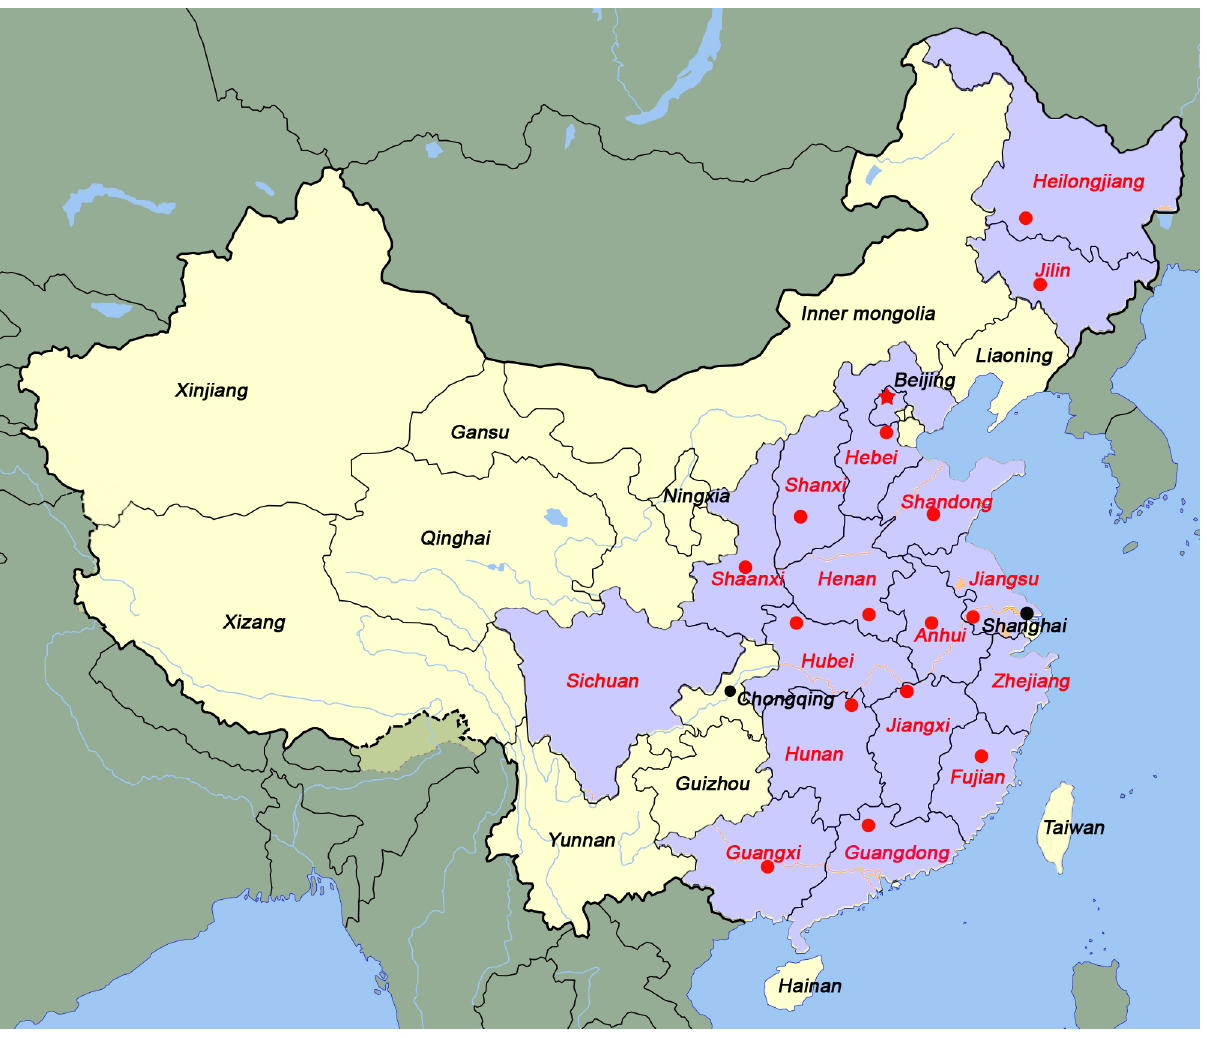
Figure 1. Locations where wild cats, dogs and fishes were captured. Field sites are shown in relation to the ranges of the 17 proposed provinces (marked with red and purple) in mainland China. International borders and major rivers are also shown in the figure.